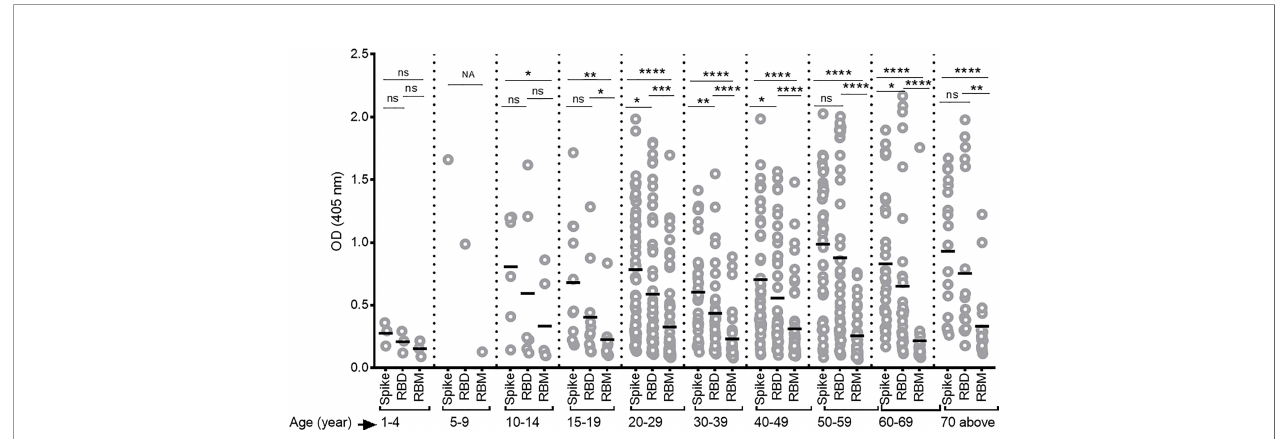
FIGURE 4 | Differing antibody responses against S, receptor-binding domain (RBD), and receptor-binding motif (RBM) according to different age groups of COVID- 19 patients. Antibody responses against S, RBD, and RBM were studied for each age group of COVID-19 patients. A correlation was observed between increasing antibody levels and increasing age. The average Ab response (mean optical density (OD)) against each antigen was calculated for each age group. Comparisons were made using an unpaired t-test to study the difference in responses against each antigen within each age group. NA, not applicable; * p < 0.05; ** p < 0. 01; *** p < 0.001; **** p < 0.0001. ns, not signi fi cant; Age (year), age ranges in years.